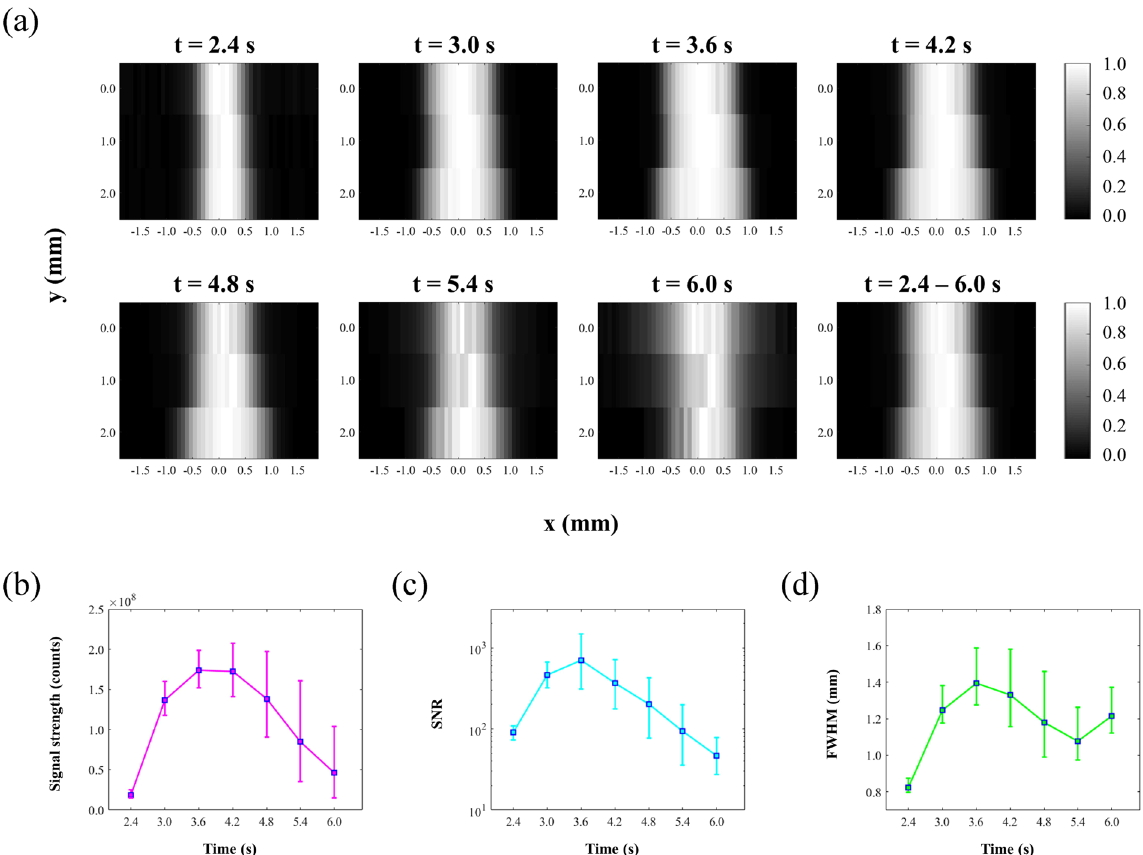
Figure 3. ( a ) USF images of the silicone tube when counting USF signal from different CCD camera recording time t = 2.4 s, 3.0 s, … 6.0 s. ( b ) Relationship between USF signal strength acquired on the center of the tube and CCD camera recording time. ( c ) Relationship between the signal-to-noise ratio (SNR) of USF images and CCD camera recording time t. ( d ) Relationship between the full width at half maximum (FWHM) of imaged tube and CCD camera recording time